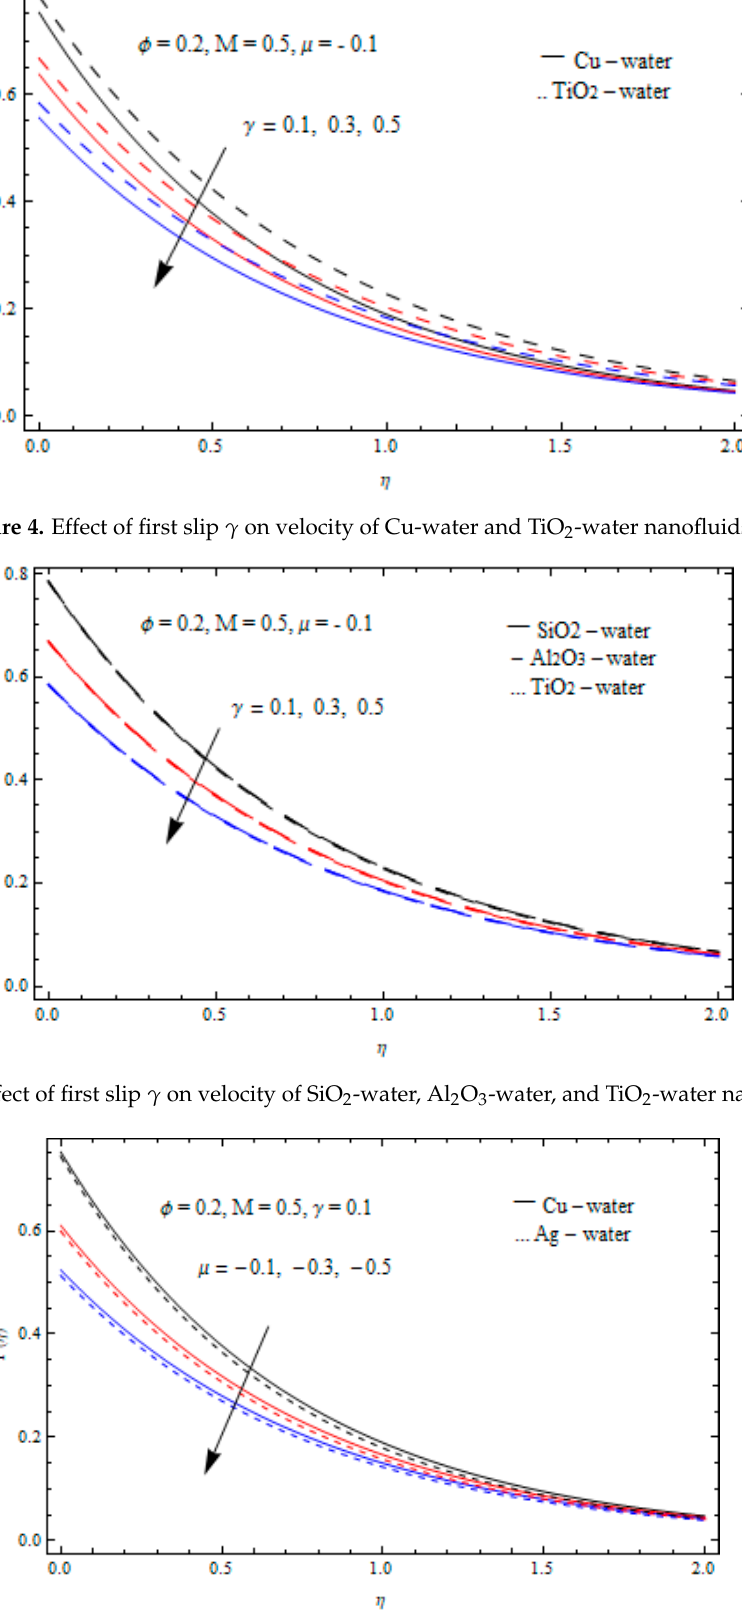
Figure 6. Effect of second slip µ on velocity of Cu-water and Ag-water nanofluids.